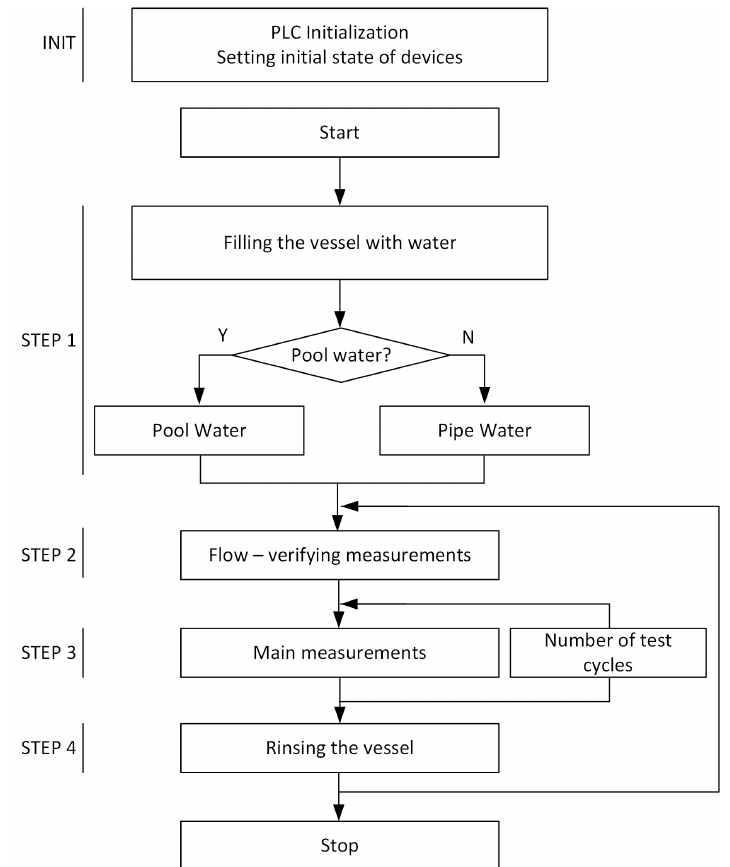
Figure 9. Operational algorithm of the